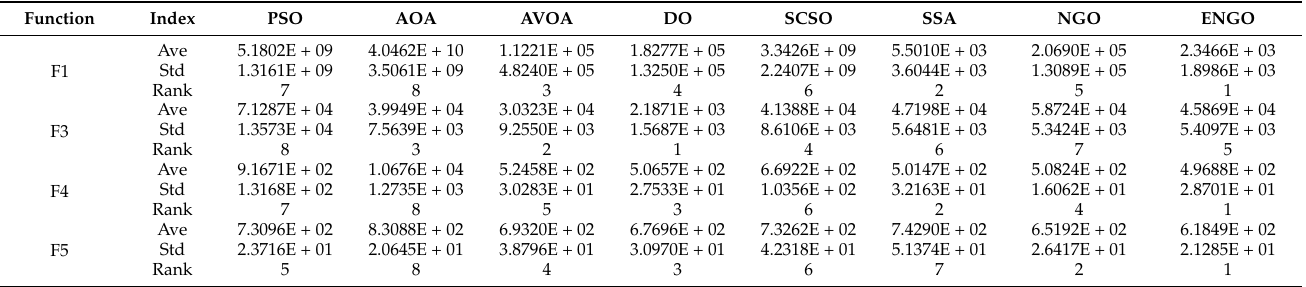
Table 2. Results of the different algorithms on the CEC2017